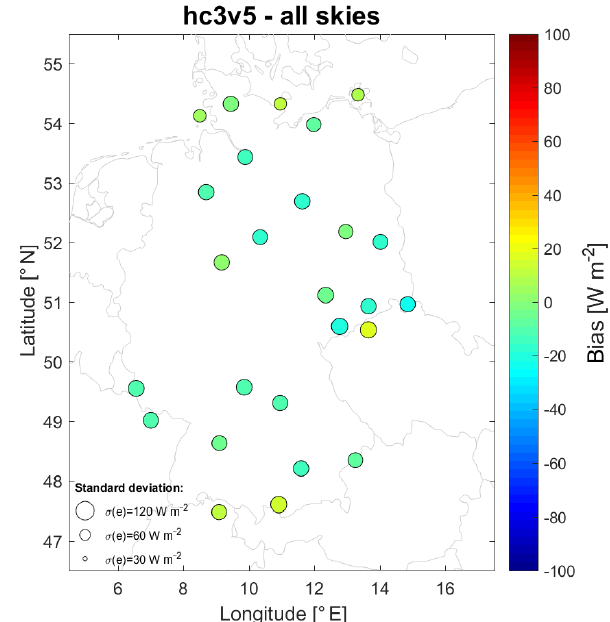
Figure 4. Map of the bias (colour) and standard deviation (diame- ter of circle) for HC3v5 for all skies conditions at the 26 selected